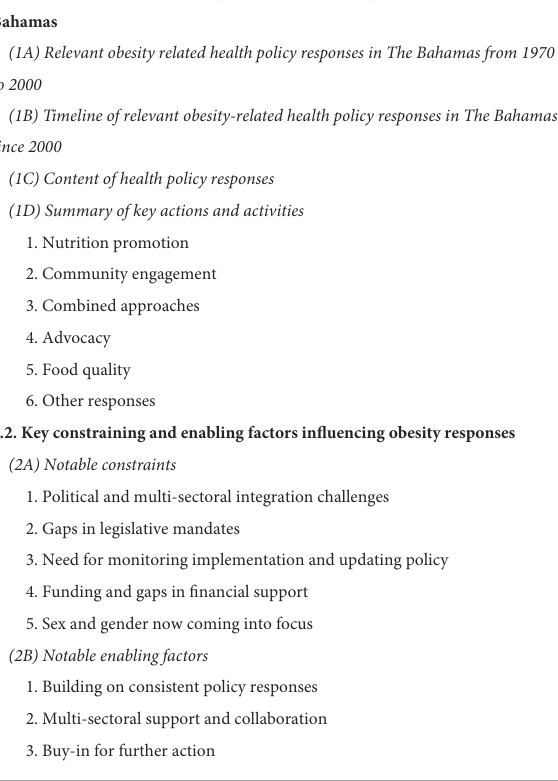
TABLE 1 Organisation of results according to a summary of